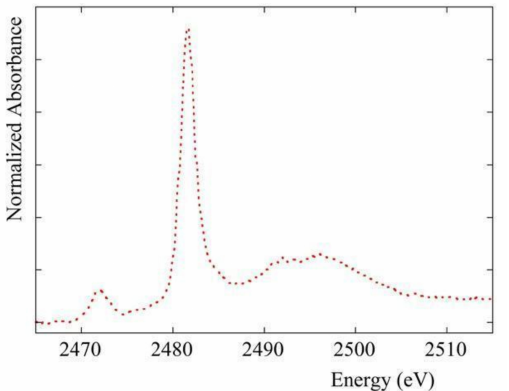
Figure 2. XAS near edge region spectrum of a lazurite sample with its typical pre-edge peak over 2470 eV, measured in the transmission mode.